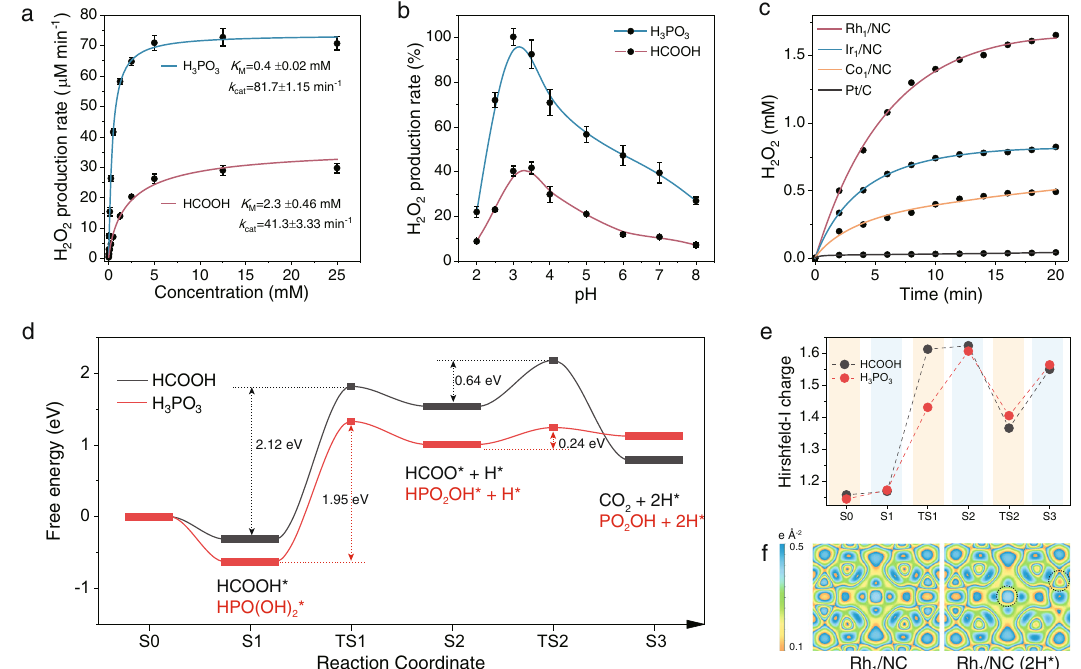
Fig. 4 Rh 1 /NC catalyzes HCOOH and H 2 PO 3 oxidation for H 2 O 2 production. a Initial H 2 O 2 production rates ( V 0 ) in Rh 1 /NC (10 μ g mL − 1 )-catalyzed HCOOH and H 3 PO 3 oxidation reactions. The V 0 values were fi tted to the standard Michaelis − Menten equation. b pH-dependent H 2 O 2 production rate in the Rh 1 /NC-catalyzed HCOOH and H 3 PO 3 oxidation reaction. c Time-dependent H 2 O 2 concentration in 2.5 mM H 3 PO 3 + 2.5 mM KH 2 PO 3 in the presence of different catalysts (50 μ g mL − 1 for single-atom catalysts, 5 μ g mL − 1 for Pt/C). d Free energy pro fi les for oxidative dehydrogenation of HCOOH and H 3 PO 3 catalyzed by Rh 1 /NC through the formate and phosphite pathway (without the assistance of a Brønsted base). e Hirshfeld-I charge of Rh at different reaction coordinates. f Charge density difference of Rh 1 /NC and Rh 1 /NC adsorbed with 2H. The inserted black circle indicates the adsorption site of H. Data (Fig. 4a, b) are presented as mean values (SD). (The error bar represents the standard deviation of 3 independent measurements).